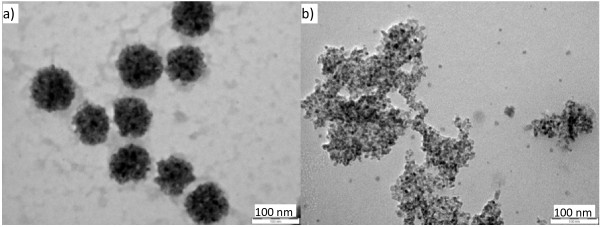
TEM images of as-synthesized bare TiO2NP aggregates (a) and hydrothermally aged TiO2NPs (b). The latter (in a mixture of EtOH/H2O = 1:1.5 at 150 °C for 24 h) are from a non-stoichiometric synchronous feeding at a molar rate of MLi2O/MTiCl4 = 1.8:1.